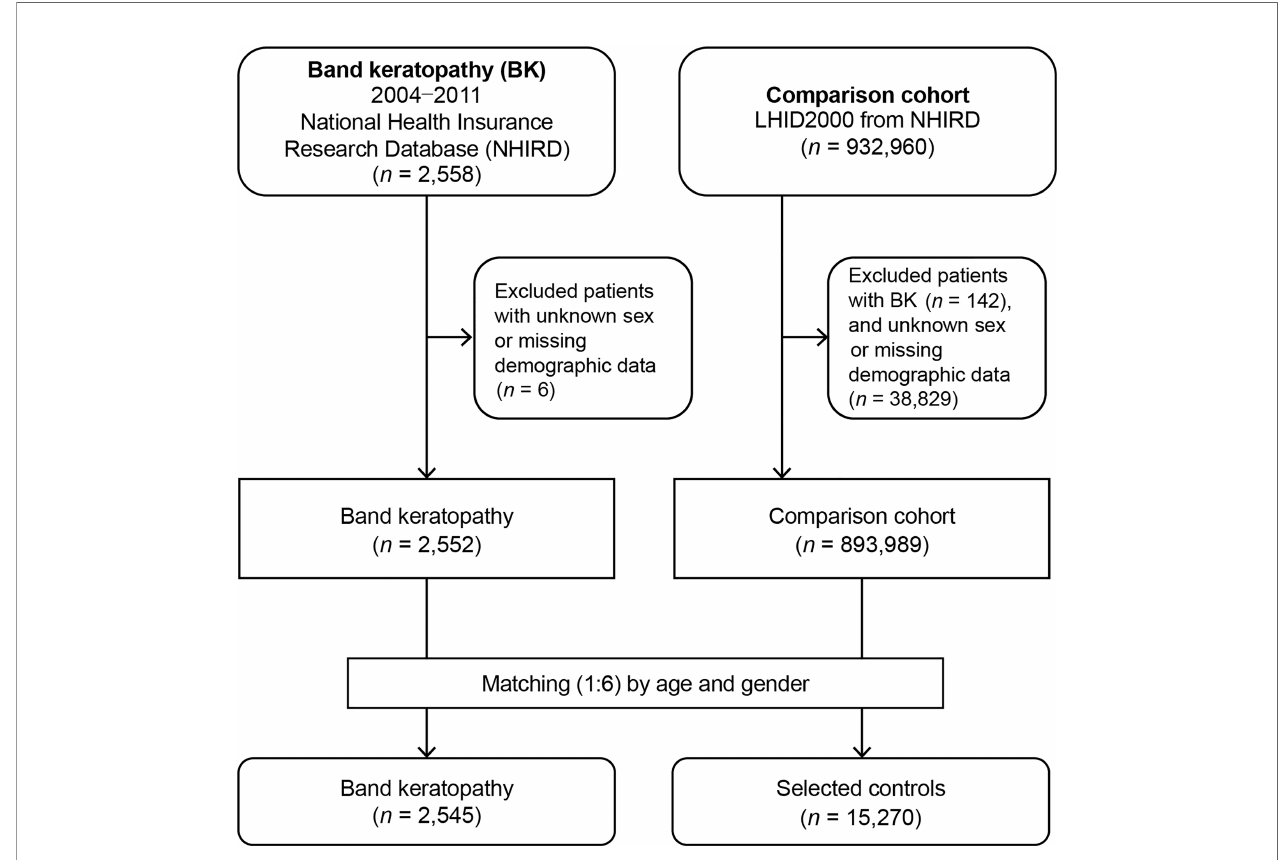
FIGURE 1 | Flowchart demonstrating the enrollment of patients with band keratopathy and